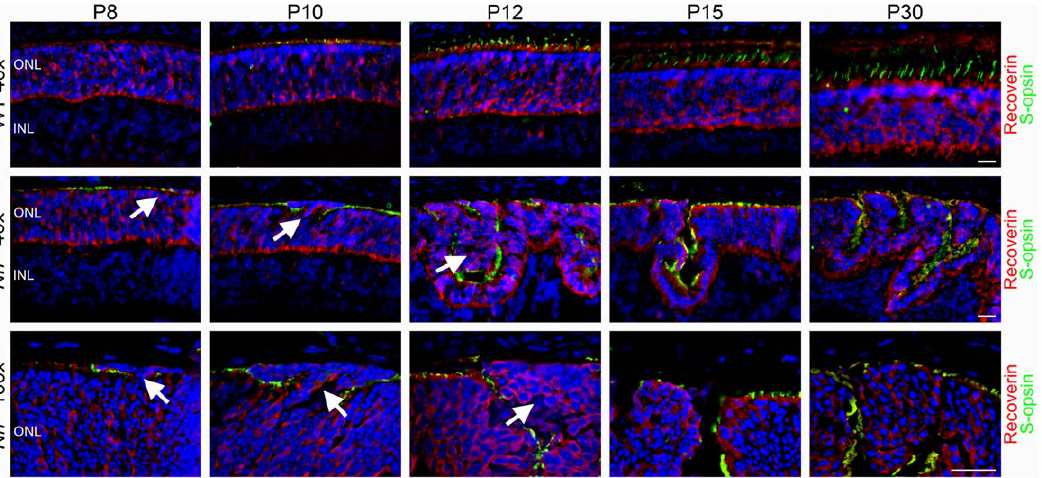
Figure 3. Rosette-associated aberrant cells are photoreceptors. Photoreceptor cell bodies were labeled using an antibody against recoverin (red) while OSs were stained using S-opsin (green) to aid in the identification of aberrant cells. All aberrant cells stain positive for recoverin (arrows) at all time points examined. ONL: outer nuclear layer, INL: inner nuclear layer. Scale bar, 20 m m.